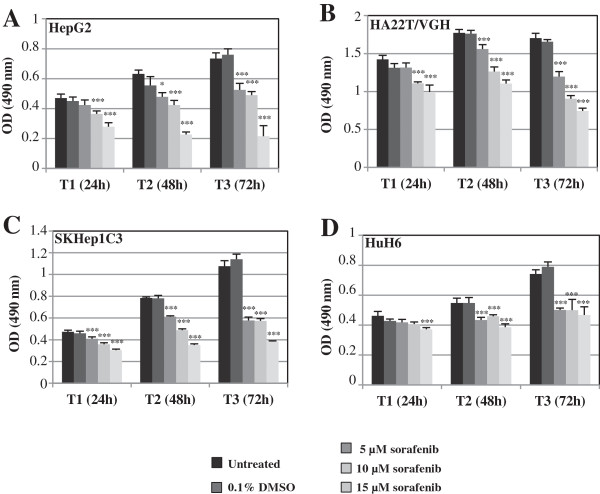
Effects of the sorafenib treatment on HCC cell lines. The HepG2, HA22T/VGH, SKHep1C3 and HuH6 cell lines were treated with sorafenib (5, 10, 15 μM concentration) for 3 days (24, 48 and 72 h). The proliferation was inhibited in a dose-dependent manner in all the cell lines considered (A-D). The most responsive HCC cell line was HepG2 (the highest percentage of the inhibition of proliferation was 72% with 15 μM of sorafenib at T = 72 h) (A). Statistical significance was determined by one way ANOVA with Bonferroni correction *p < 0.05; ***p < 0.001.